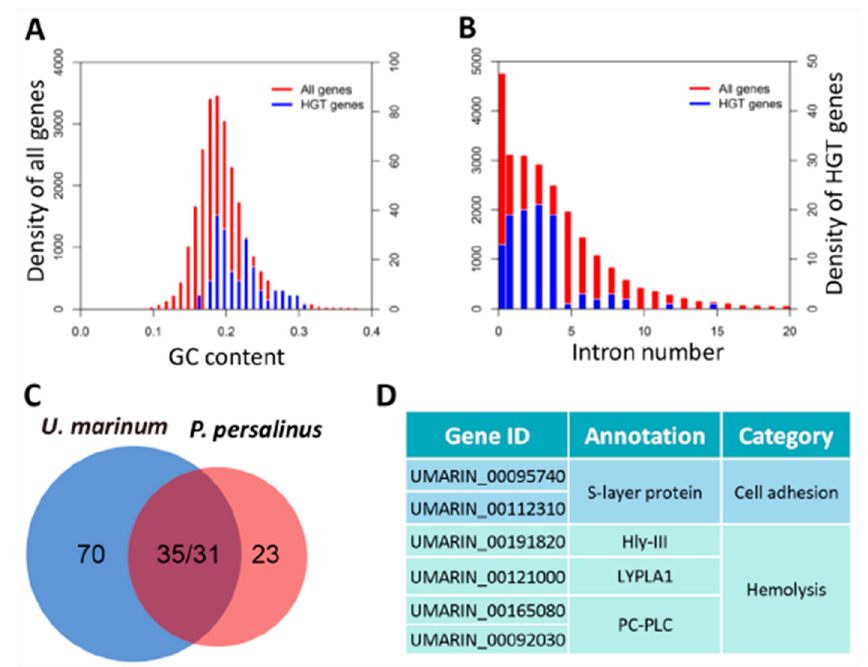
Figure 2. Horizontal gene transfer (HGT) genes in U. marinum . ( A ) Guanine-cytosine (GC) content of the 105 HGT genes. ( B ) Distribution of intron number in the 105 HGT genes. ( C ) Venn diagram showing the numbers of specific and homologous HGT genes in U. marinum and P. persalinus . ( D ) Potential hemolysis-related HGT genes identified in U. marinum .